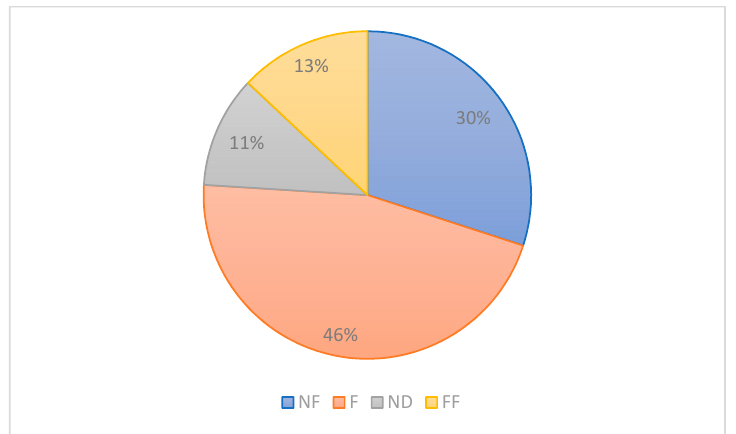
Figure 5. Results of the experiments in the morning for the morning circadian chrono-type.